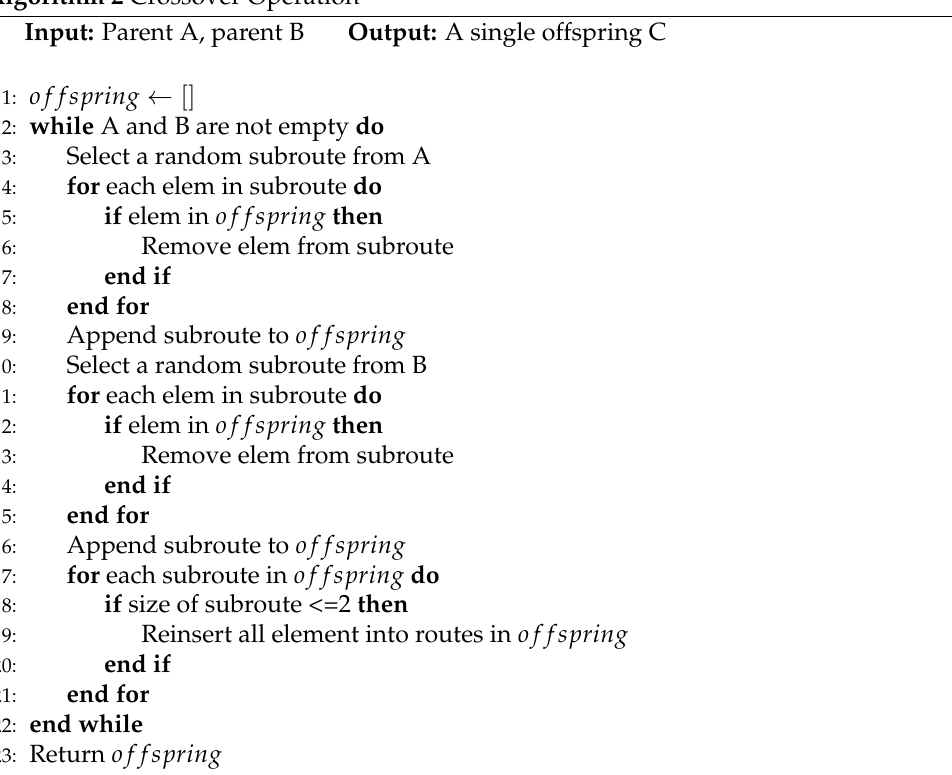
Algorithm 2 Crossover